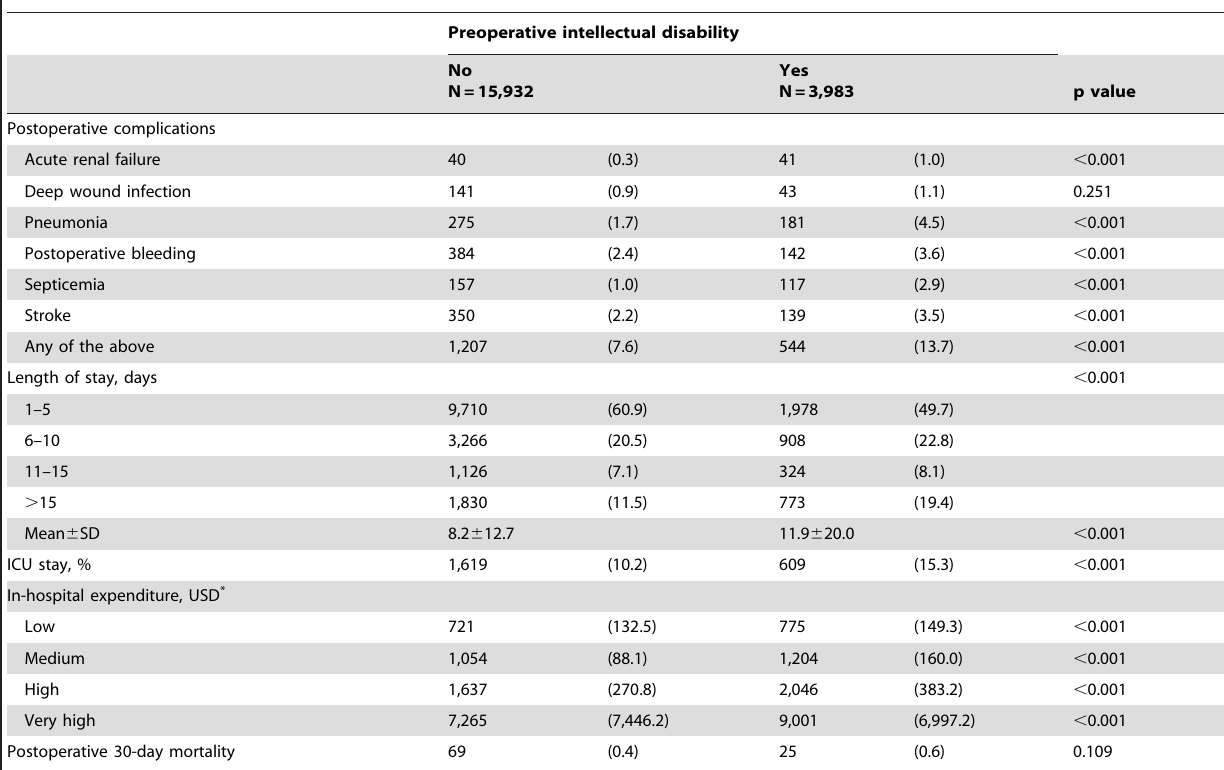
Table 1. Outcome characteristics of surgical patients with intellectual disability and controls.